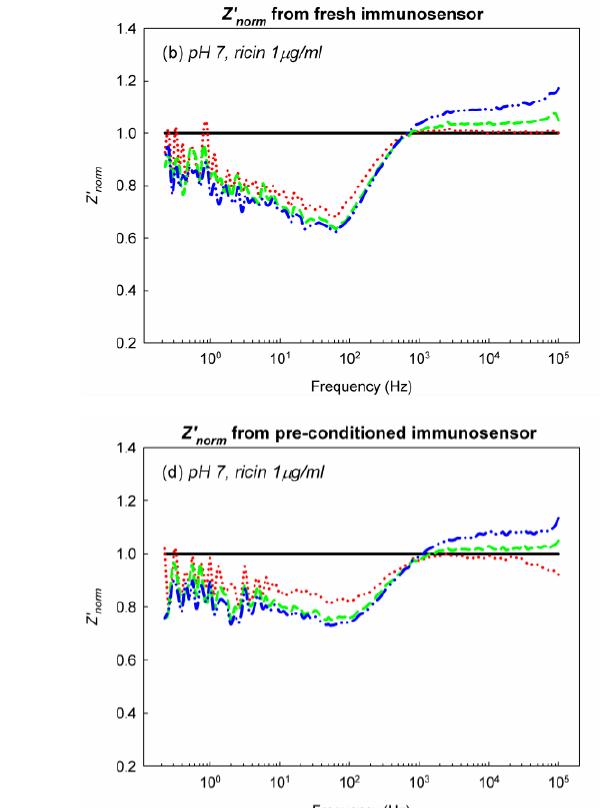
Figure 4. Z’ spectra from EIS analysis of EII at pH 7; for the fresh EII with the norm treatment of (a) 0 μg/mL and (b) 1 μg/mL of Ag; and for preconditioned-EII with the